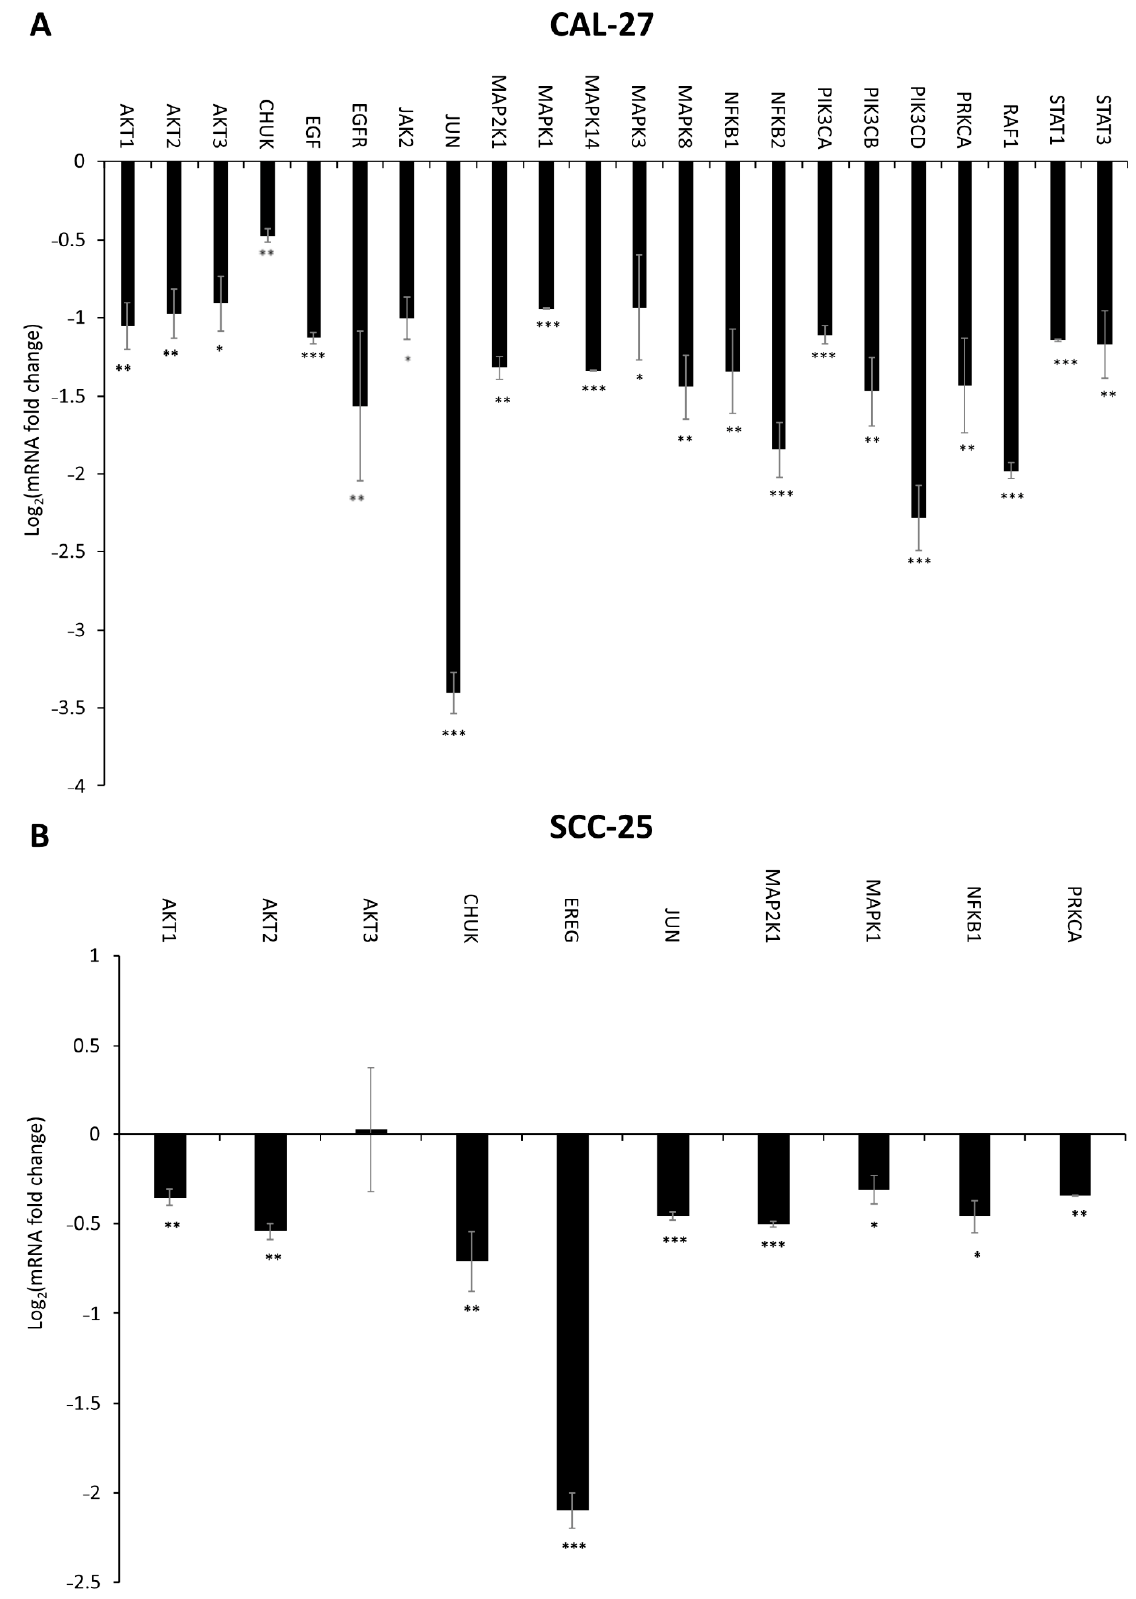
Figure 8. The effect of the combination of DMU-214 (1.0 μ M) and Gef (5.0 μ M) on the expression of EGFR signaling pathway-related genes in CAL-27 ( A ) and SCC-25 ( B ) cell lines. Results of three independent replicates are presented as mean ± SD. *** p < 0.001, ** p < 0.01, * p < 0.05 indicate a significant difference from the control.